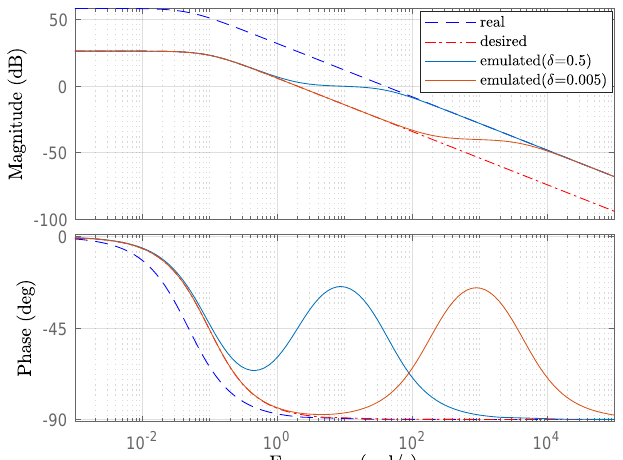
Figure 4. Frequency responses of the real dynamics (4a), desired dynamics (4b) and emulated dynamics (5) for different δ ’s with J em = 20 J and B em = 40 B